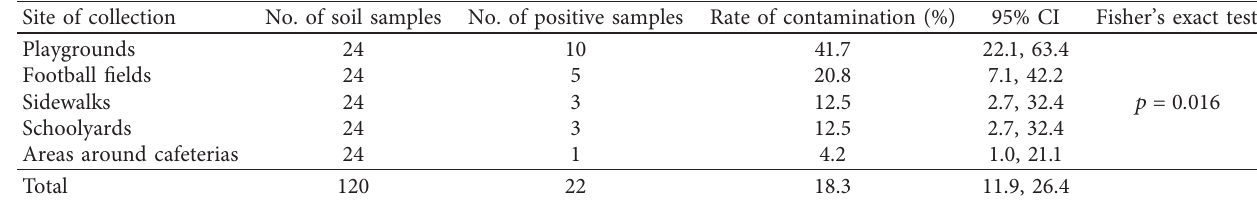
Table 2: Contamination rate of Toxocara eggs in the different sampling areas.